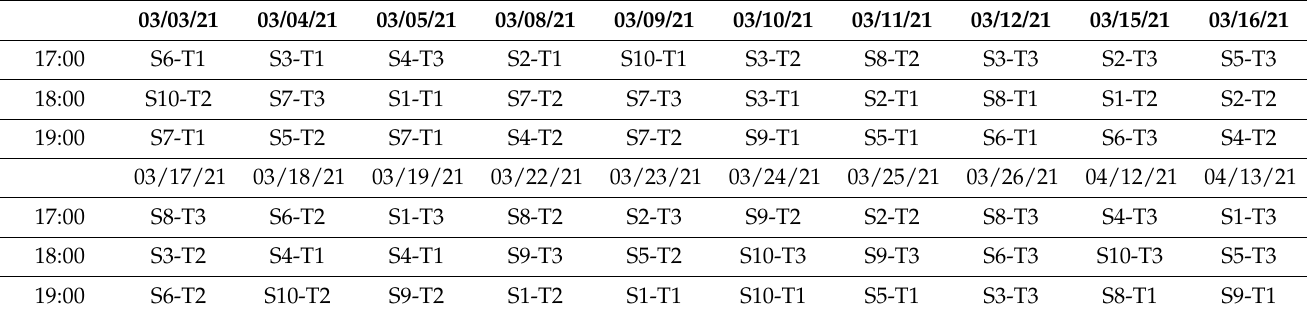
Table 1. Subjects’ session